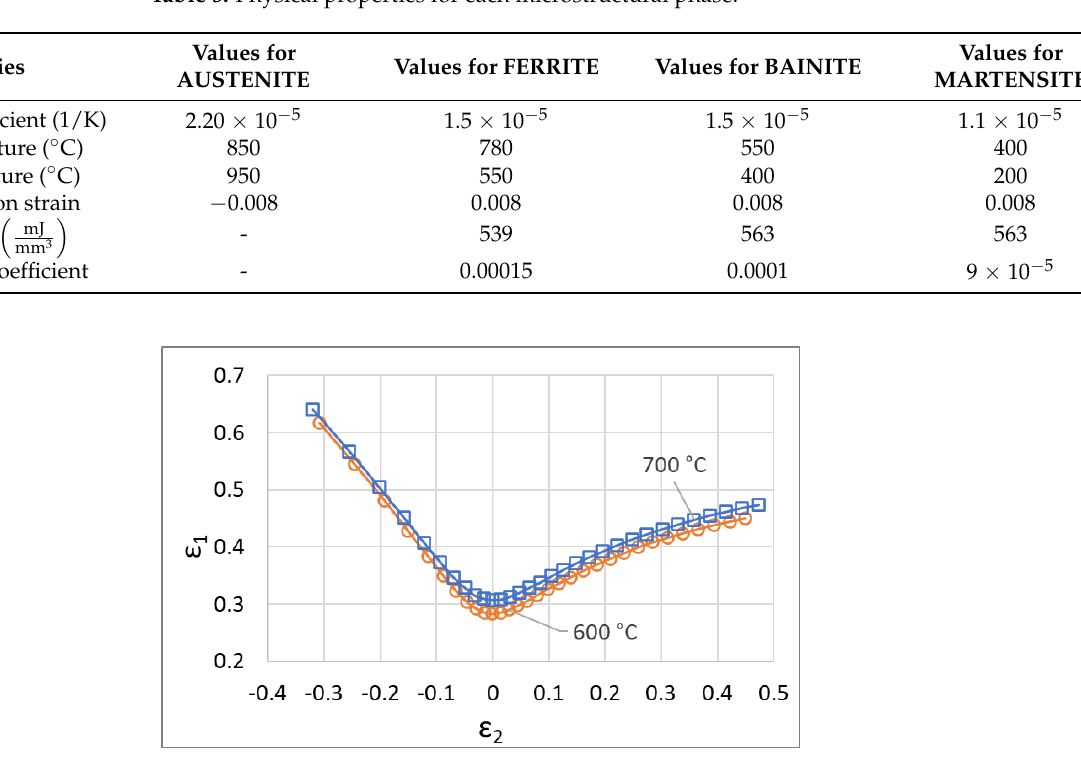
Table 5. Physical properties for each microstructural phase.